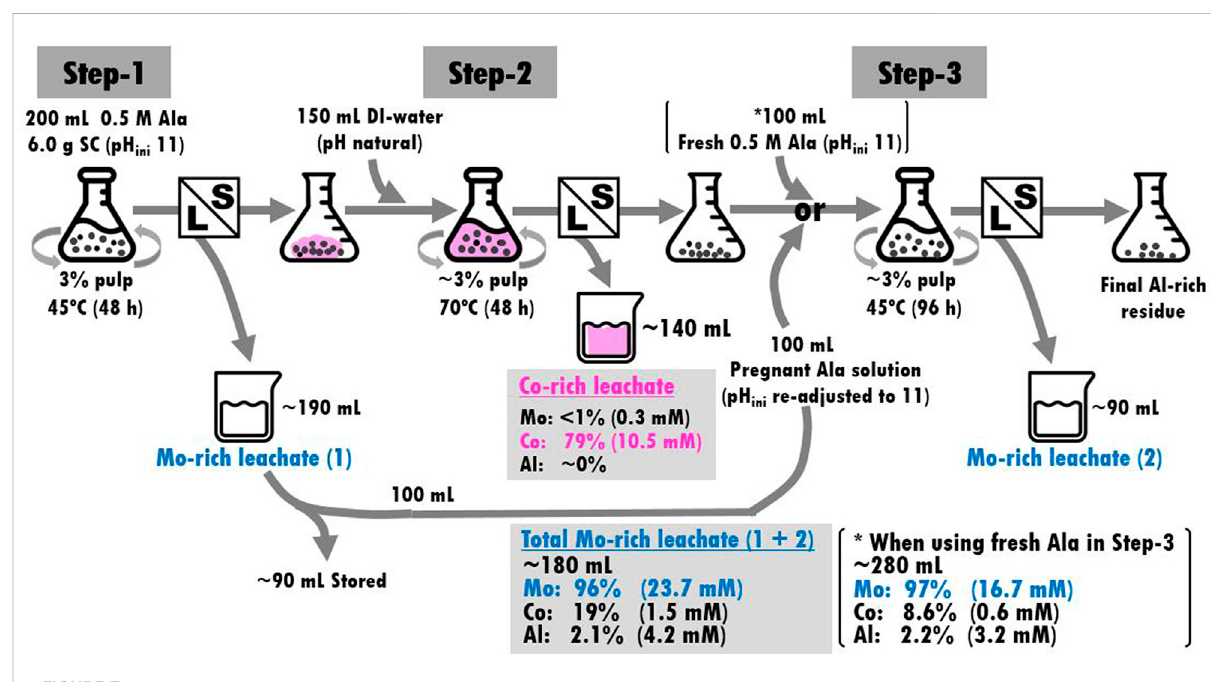
FIGURE 7 The overview of 3-step leaching fl ow and the resultant metal contents of Co-rich and Mo-rich leachates.